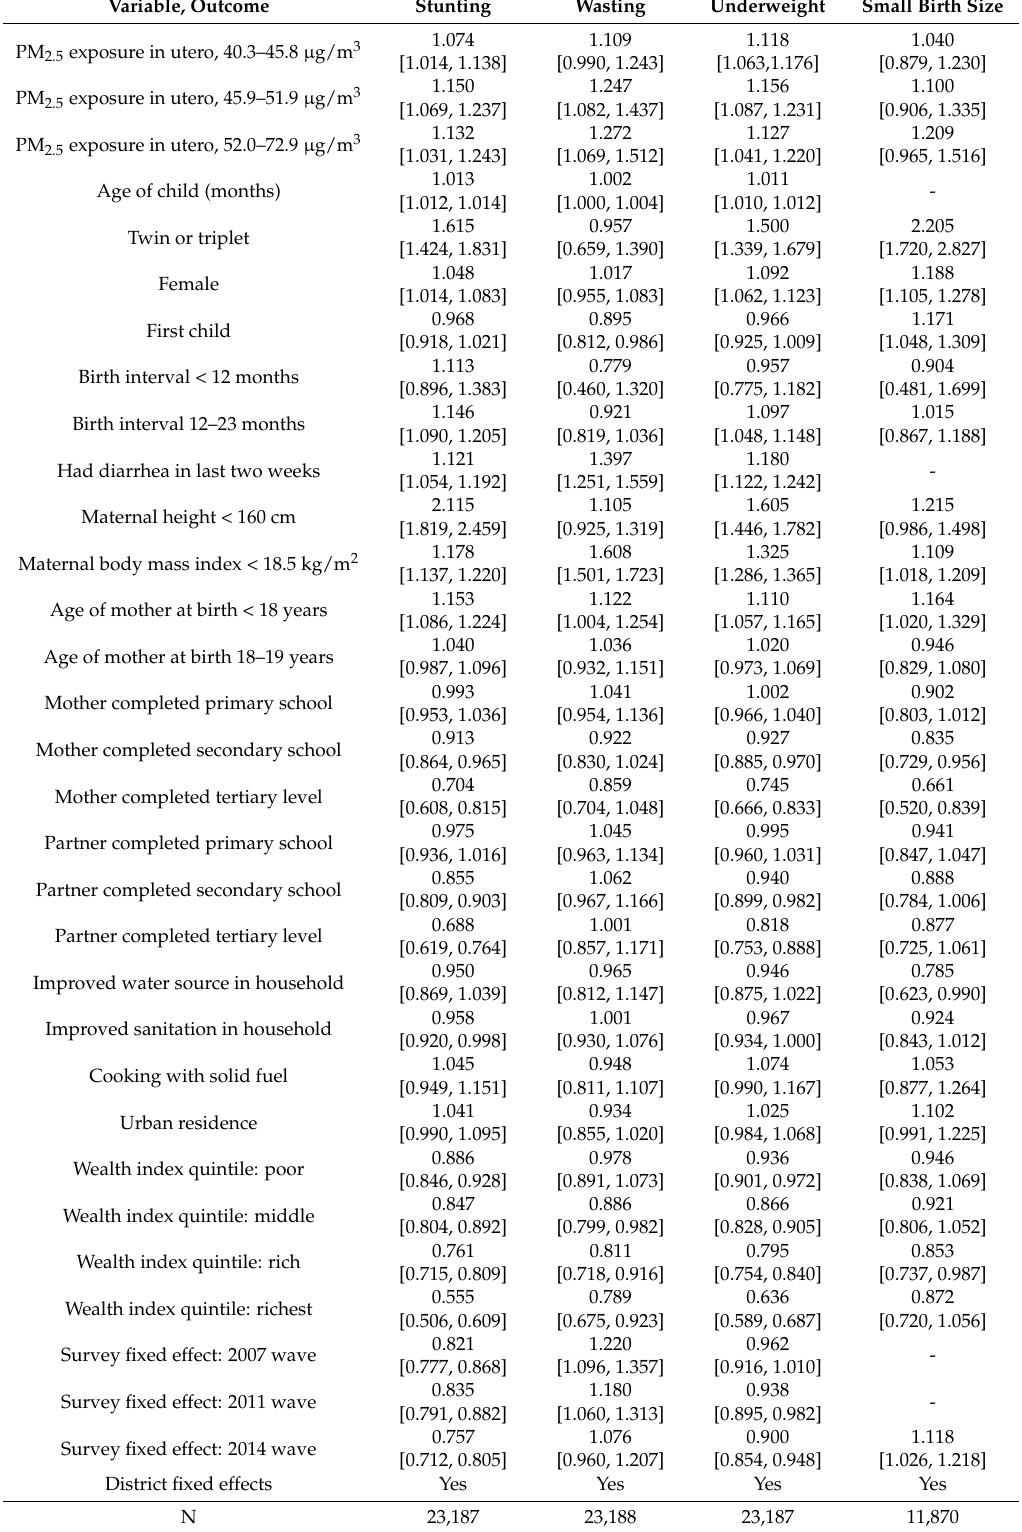
Table 2. Association between in utero PM 2.5 exposure and child anthropometric